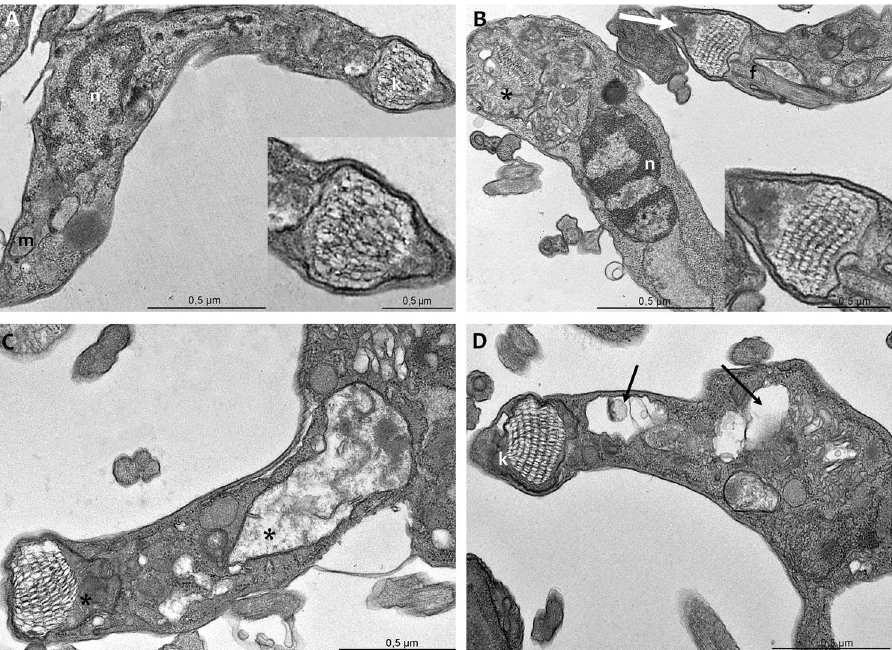
Figure 9. Transmission electron microscopy of T. cruzi trypomastigotes in the presence of FEX for 24 h. ( A ) Non-treated parasites present an elongated shape, an oval nucleus (n), a single branched mitochondrion (m), and a more relaxed basket-shaped kDNA (k). ( B ) Ten micromolar caused mitochondrial swelling (asterisk) and the appearance of unusual electron-dense content between the kDNA and the mitochondrial membrane (white arrow). ( C ) With 30 µM, parasites presented mitochondria swelling (asterisk). ( D ) Treatment with 50 µM caused vacuolization of cytoplasm (black